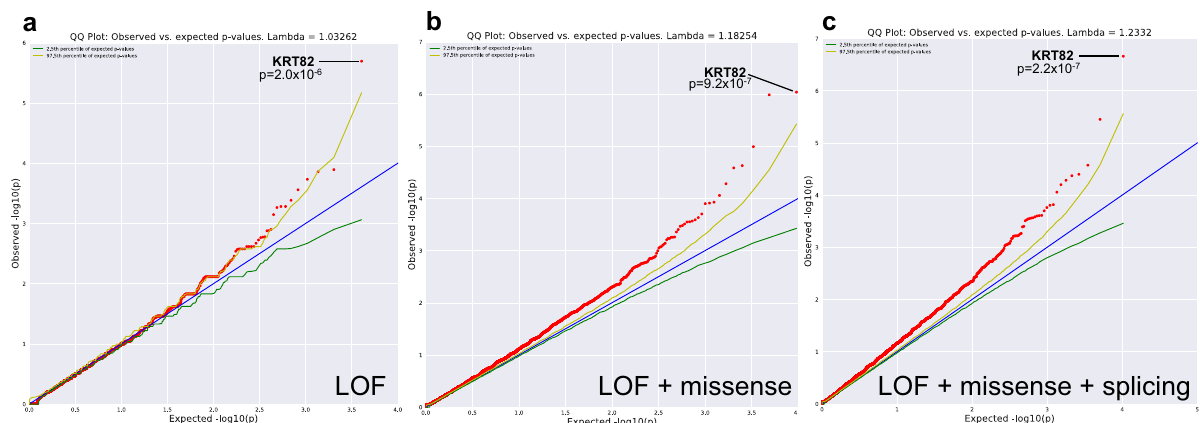
Fig. 1 Gene-level collapsing models identify signi fi cant rare variation in KRT82. Q – Q plots of a Loss of Function (LOF) Model. b LOF + damaging missense Model. c LOF + missense + splicing variants predicted by high TraP scores ( ≥ 0.2). The genomic in fl ation factor ( λ ) is 1.03, 1.18, 1.23, respectively. The blue line represents the null hypothesis (observed p -values correspond to expected p -values), the yellow line marks the 2.5th percentile of expected p-values, and the green line marks the 97.5th percentile of expected p -values. p -value was determined by two-tailed Fisher ’ s exact test (FET). Table 1 Case and control frequencies of collapsing models ’ qualifying variants in the top three most signi fi cant genes. Model